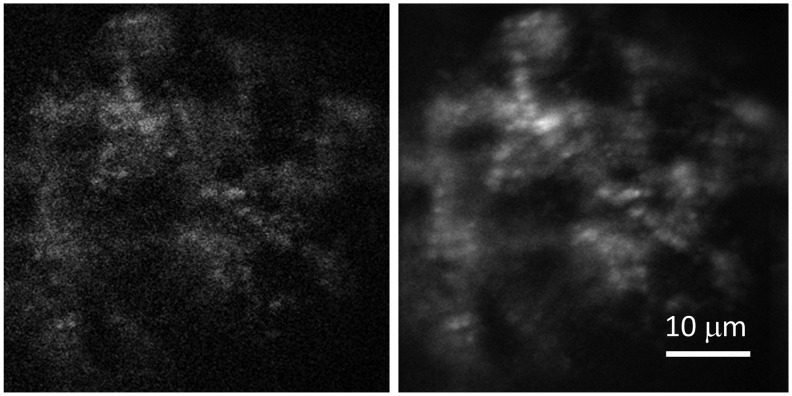
A single frame (left) and an averaged image of the heart (right) running at 50–60 bpm.